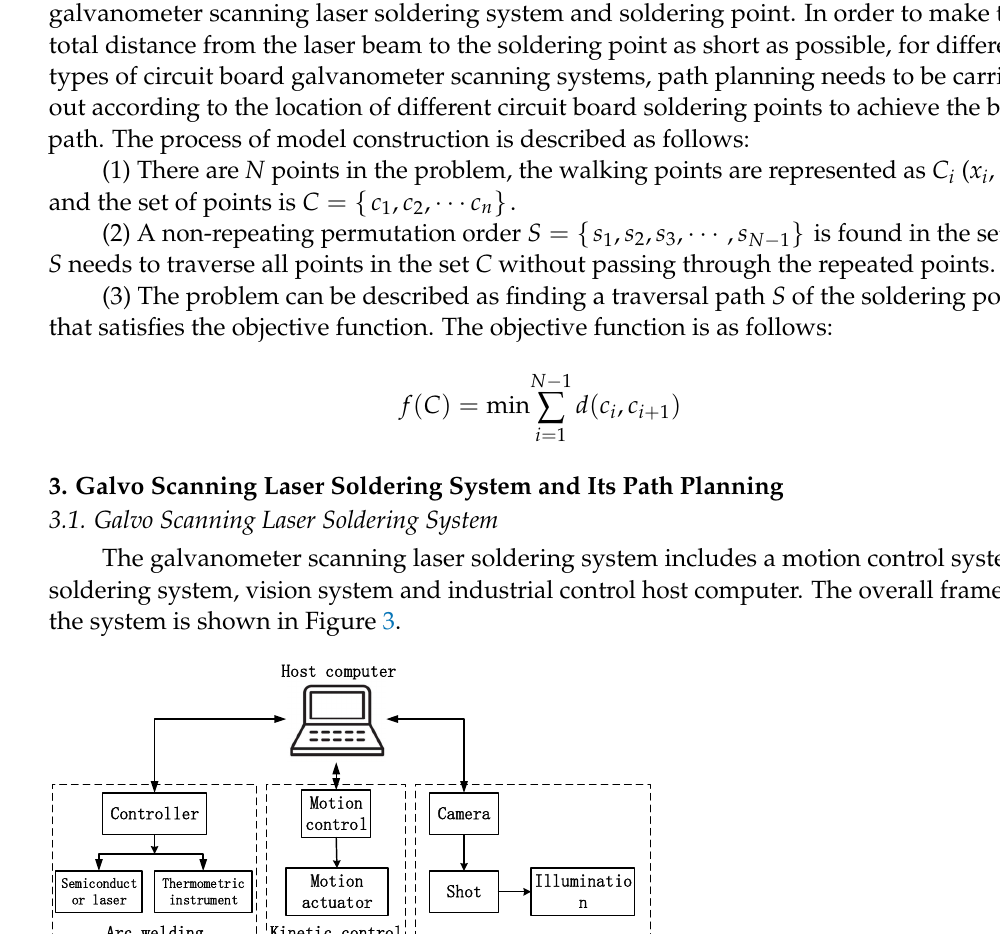
<8 Figure 4. Schematic diagram of the system motion axis structure.